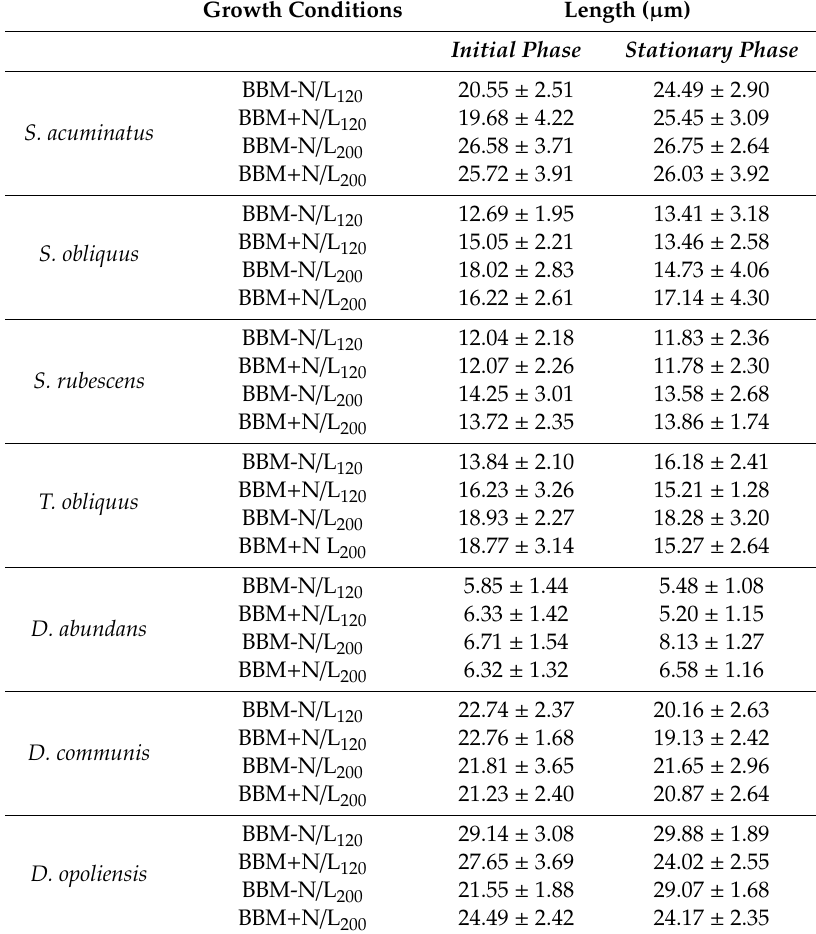
Table 3. Evaluation of cell length for all strains in the tested conditions, measured at the initial phase of the experiment and at the stationary phase. Values are means of fifty measures ± standard